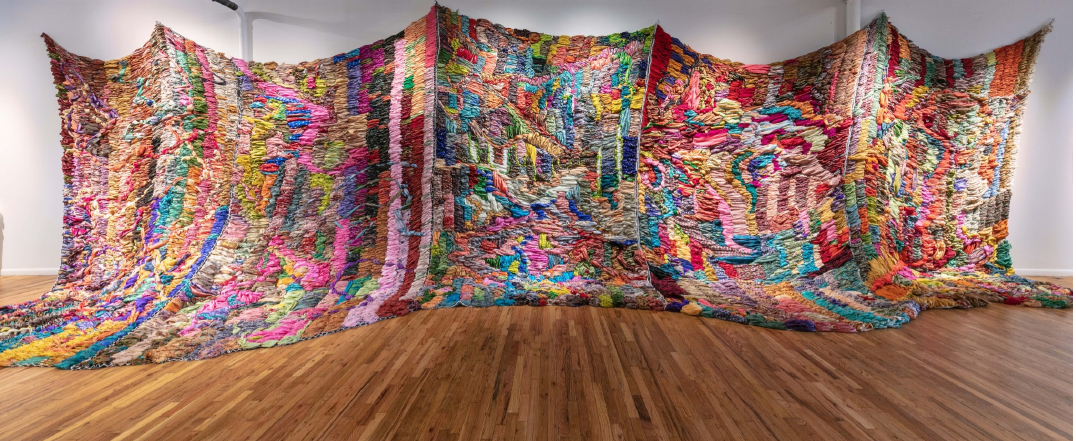
Figure 6. Suchitra Mattai, Exodus , 2019, vintage saris from India, Sharjah, artist’s Guyanese family, and rope net, 15 × 40 feet (Collection of the Momentary, Crystal Bridges Museum of American Art).